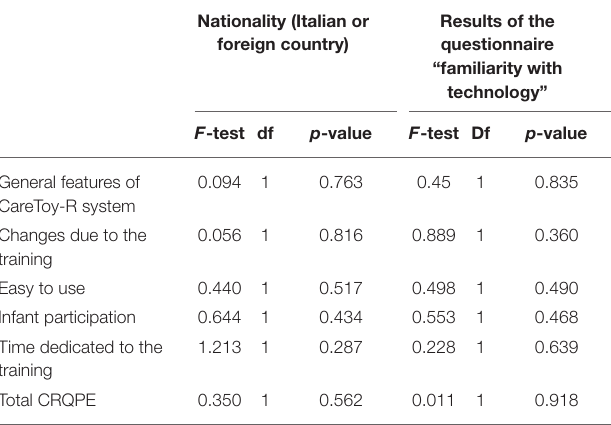
TABLE 8 | Mothers’ characteristics and CRQPE answer questionnaire. Nationality (Italian or foreign